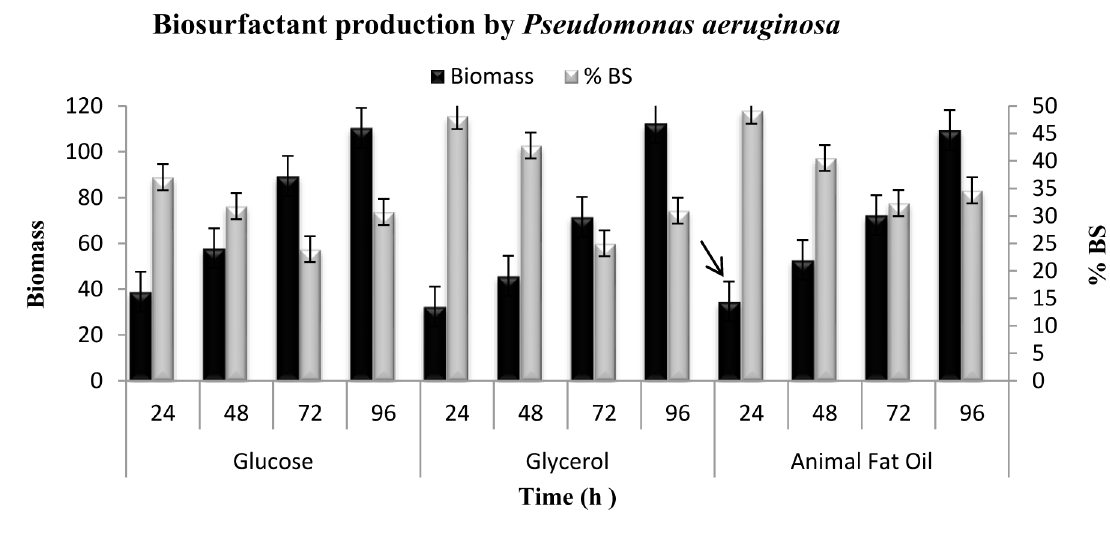
Figure 2: Time profiling for biosurfactant production by strain PWC ( Pseudomonas aeruginosa ; MH142144) showed high production on all carbon sources. Highest biosurfactant production was on animal fat oil (17.0 g/L) while lowest biosurfactant production was on glucose (14.4 g/L). Biomasses are the mean of values recorded during production kinetics. Standard error of each value was